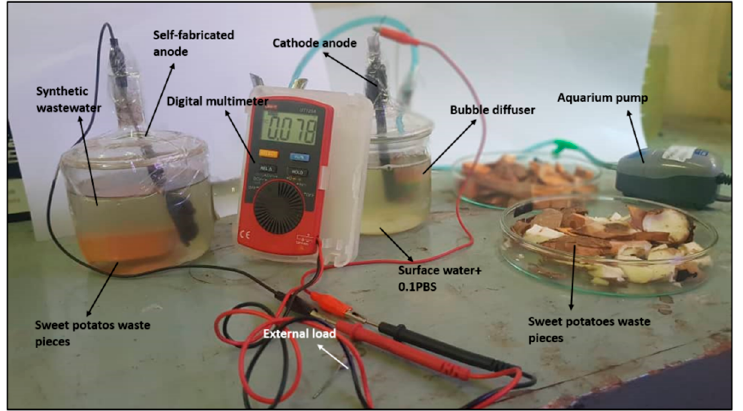
Figure 1. Operational mode of benthic microbial fuel cells (BMFCs) setup used in present study.